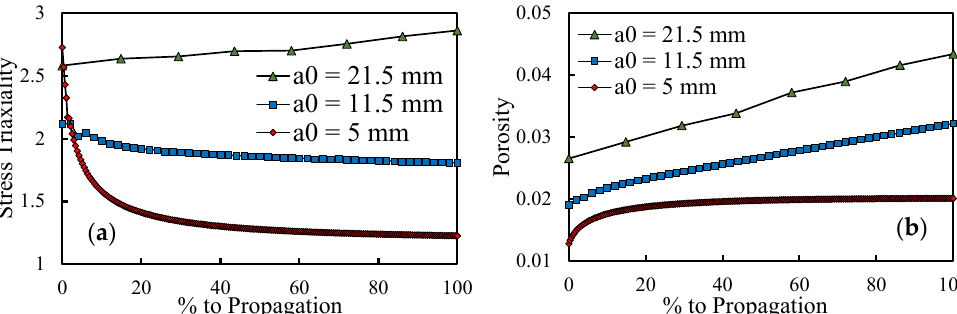
Figure 12. ( a ) Stress triaxiality throughout the entire propagation studied in Figure 4. ( b ) Porosity evolution for the same propagation.